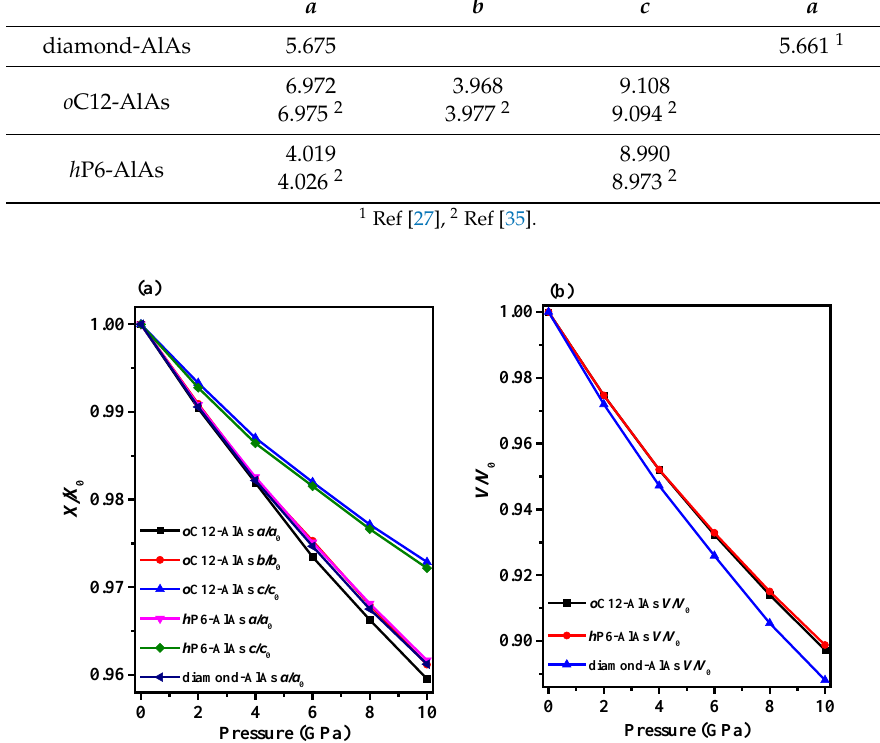
Figure 2. The lattice constants X / X 0 compression ( a ) and primitive cell volume V / V 0 ( b ) as functions of pressure for o C12-AlAs, h P6-AlAs, and diamond-AlAs.